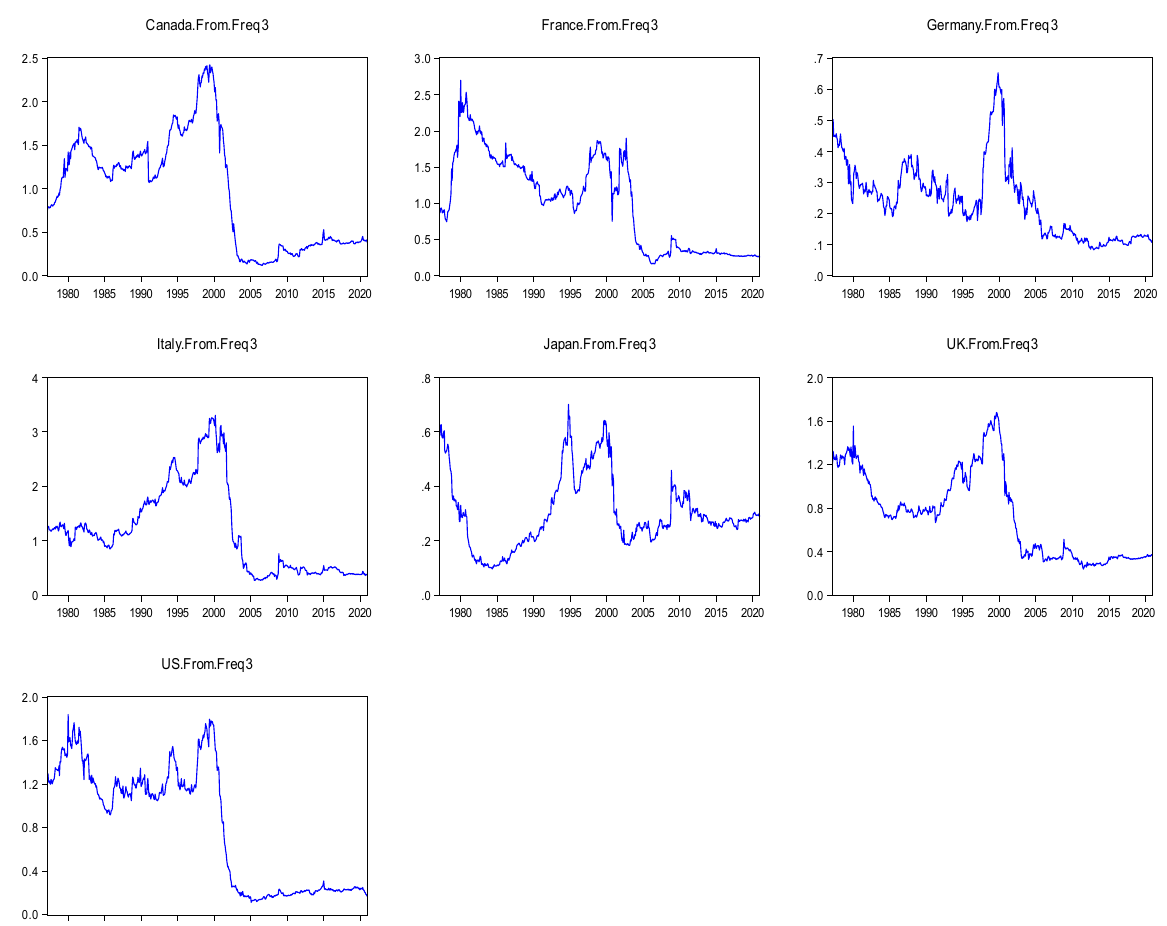
Figure 5. Inflation spillover in each of the G7 countries from other countries with the Barunik and Krehlik (2018) methodology in the long term.